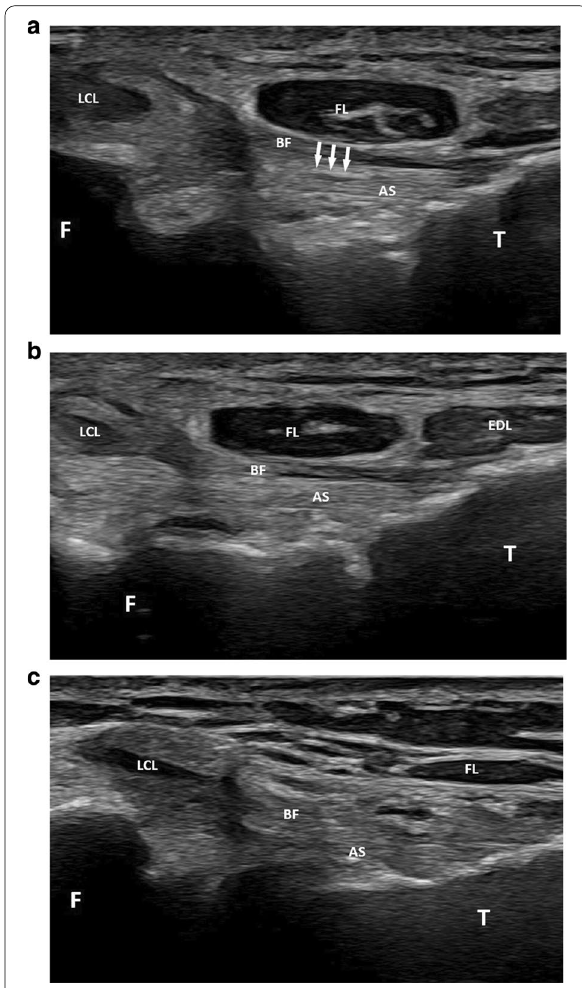
Fig. 4 Superior bundle of the anterior PTF ligament (transverse plane). a The superior bundle (AS) is well differentiated from the more superficial anterior arm of the biceps femoris muscle (BF). It extends from the anterior aspect of the styloid process and the adjacent fibular head (F) to the lateral aspect of the tibia (T). Note the hyperechoic space between them (arrows). b Close proximity between the superior bundle (AS) and the anterior arm (BF) but their different anisotropy allows their differentiation. c Close proximity between the superior bundle (AS) and the anterior arm (BF) but no clear differentiation between them due to similar anisotropy. LCL: lateral collateral ligament; FL: fibularis longus muscle; EDL: extensor digitorum longus